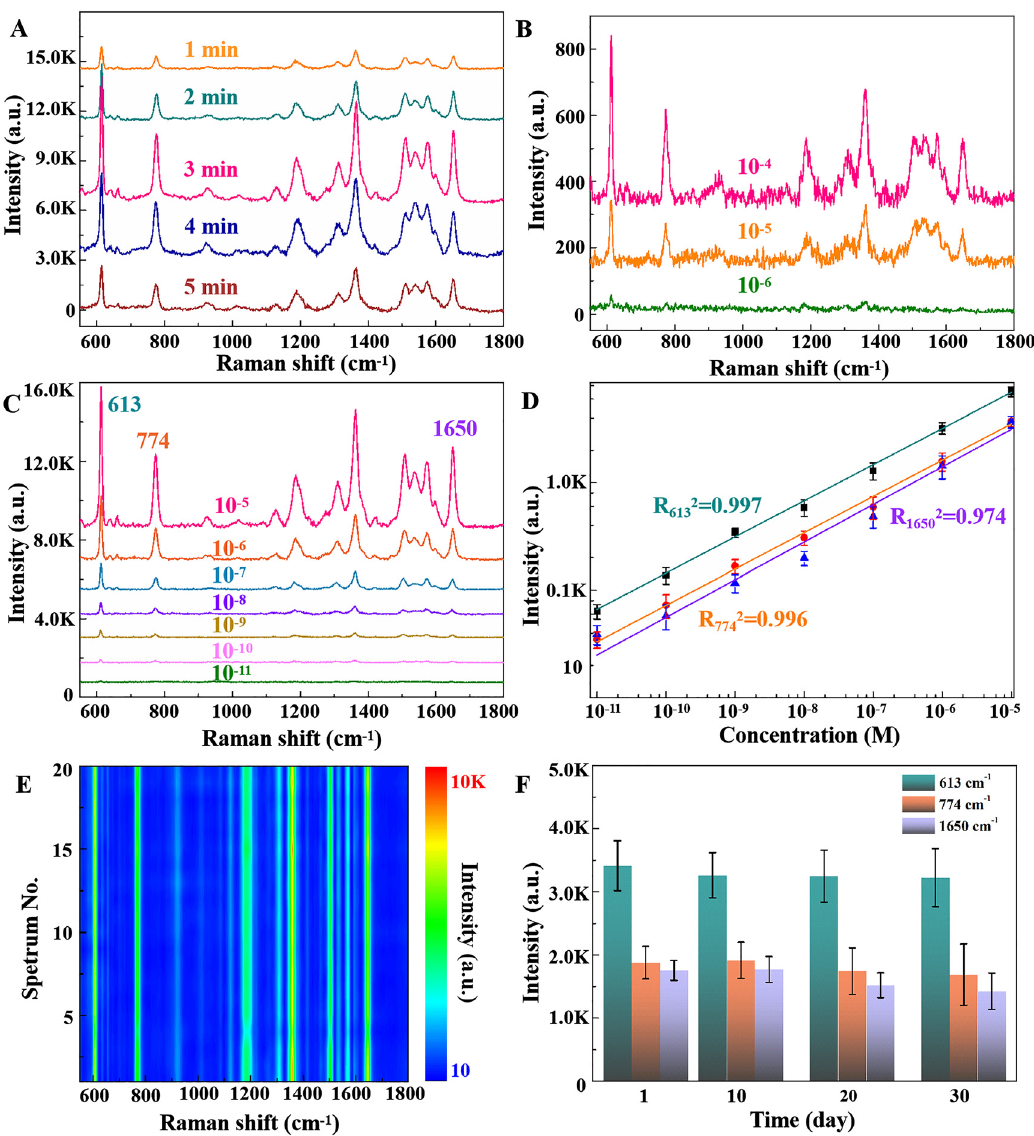
Figure 4: Surface-enhanced Raman spectroscopy (SERS) performance of R6G on different substrates. (A) Raman spectra of R6G alcoholic solution (10 − 5 M) detected on the pyramid Si (PSi)/molybdenum disul fi de (MoS 2 )/Au multiscale cavity (MSC) with different reaction time. (B) Ramanspectra of R6G alcoholic solution from 10 − 4 to 10 − 6 M on the PSi/MoS 2 MSC substrate. (C) Raman spectraofR6G(theconcentrationfrom 10 − 5 to10 − 11 M)onthePSi/MoS 2 /Au MSCSERSsubstrate.(D)Linearrelationships:Ramanintensitiesat 613, 774, and 1650 cm − 1 as a function of the concentrations of R6G molecules. (E) The contour image of R6G (10 − 5 M) detected at 20 random positions on PSi/MoS 2 /Au MSC SERS sample. (F) The stability: The intensity of three main characteristic peaks (10 − 6 M) detected on the PSi/ MoS 2 /Au MSC SERS substrate per 10